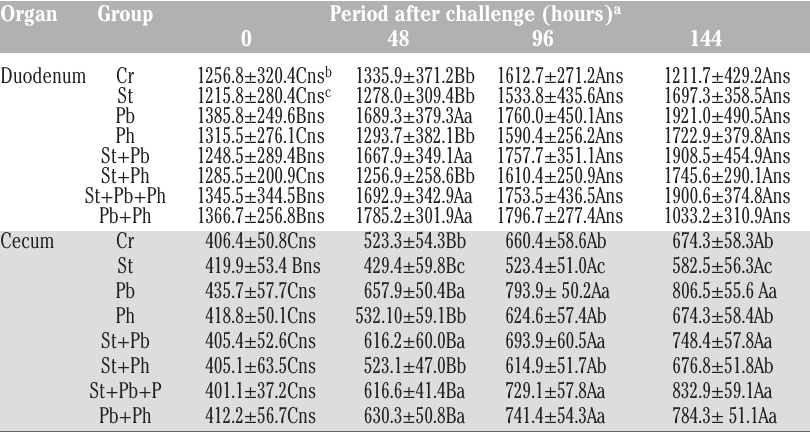
Table 4. Mean of body weight of birds challenged against Salmonella Typhimurium and treated with probiotic and bacteriophage P22. Results are expressed in grams